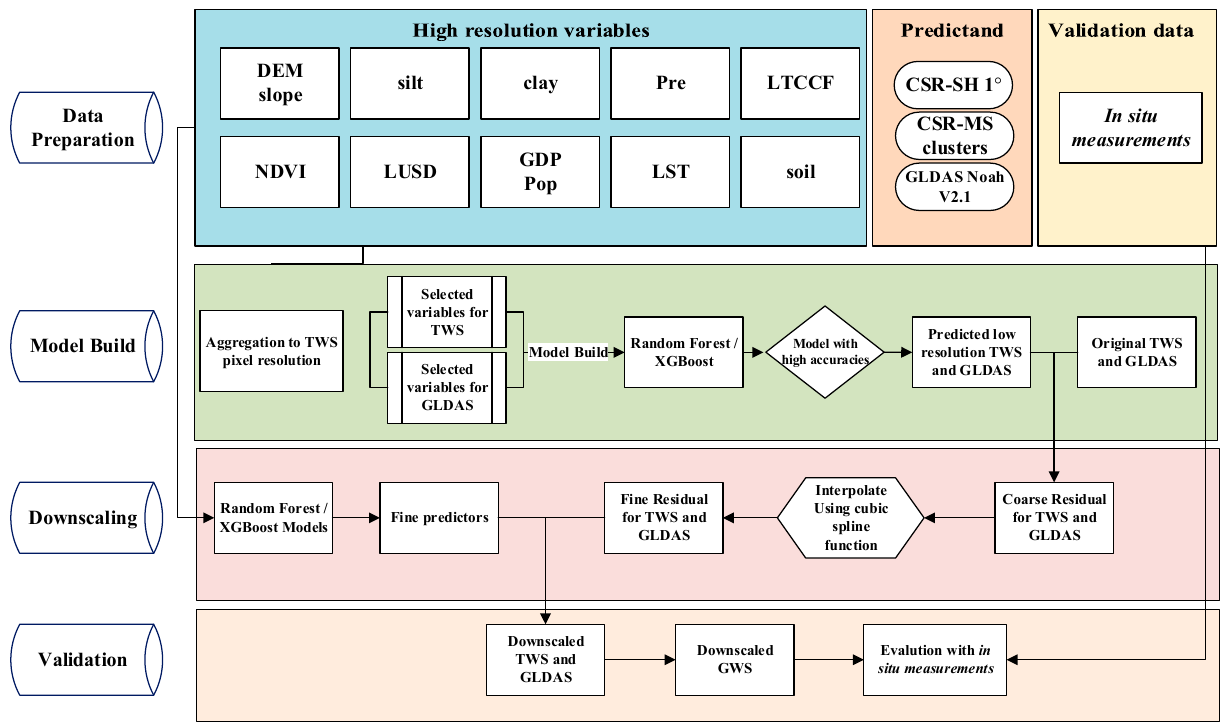
Figure 1. Methodology of the research.